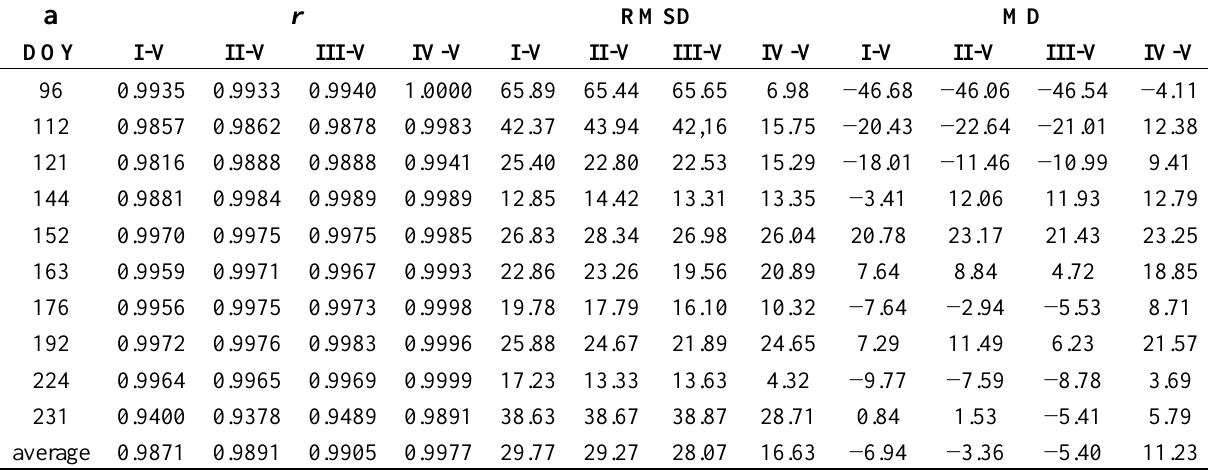
Table 2. The average of the Pearson correlation coefficient ( r ), Root Mean Square Difference (RMSD, W∙m −2 ) and Mean of Difference (MD, W∙m −2 ) of the 10 pairs of